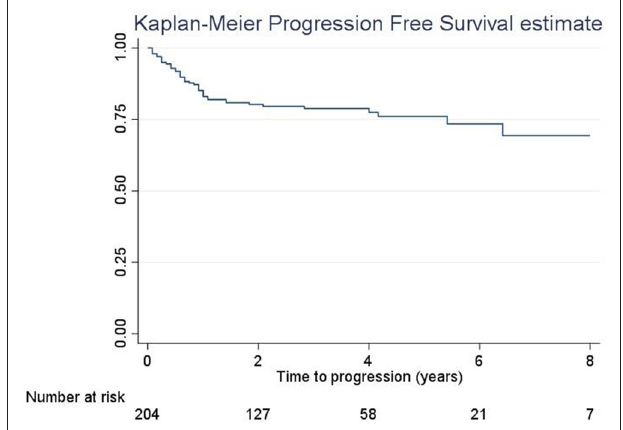
FIGURE 5 | Progression-free survival, overall.